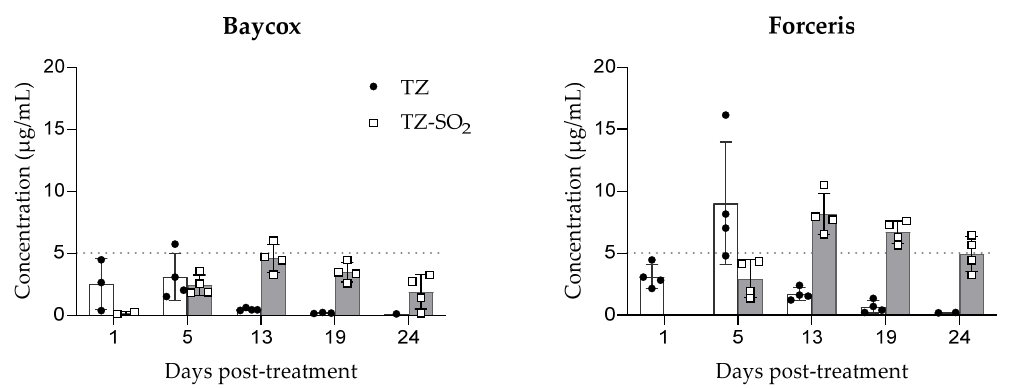
Figure 1. Plasma concentrations of toltrazuril (TZ) and toltrazuril sulfone (TZ-SO 2 ) (mean ± SD) following single oral (Baycox 5%) or intramuscular (Forceris) administration to piglets.